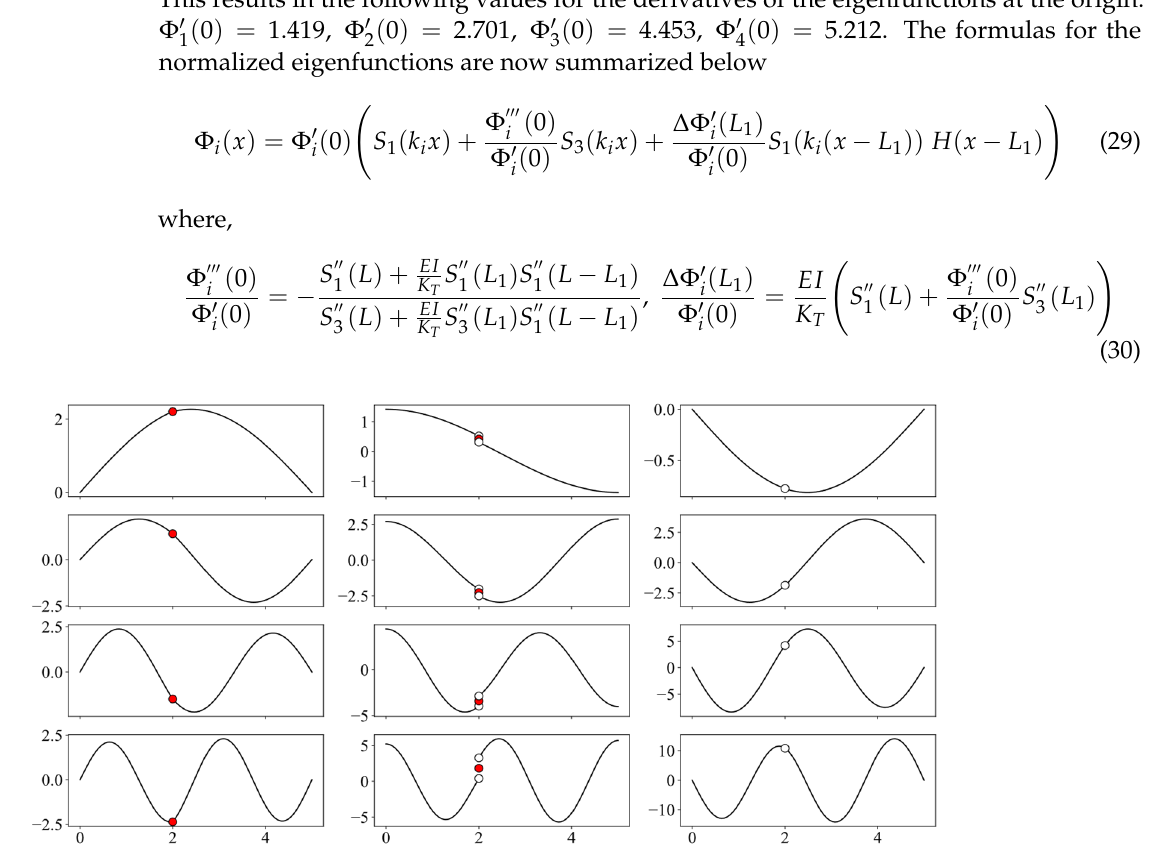
Table 2. First four eigenfrequencies 𝑓 (cid:3036) of the simply supported beam with and without a crack. Crack Length α